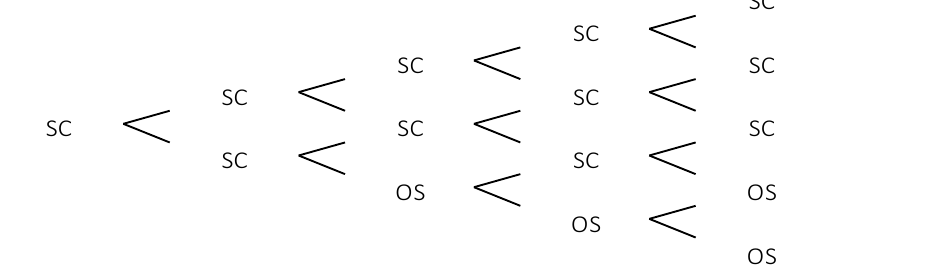
Figure 3. Decisions on the use of available